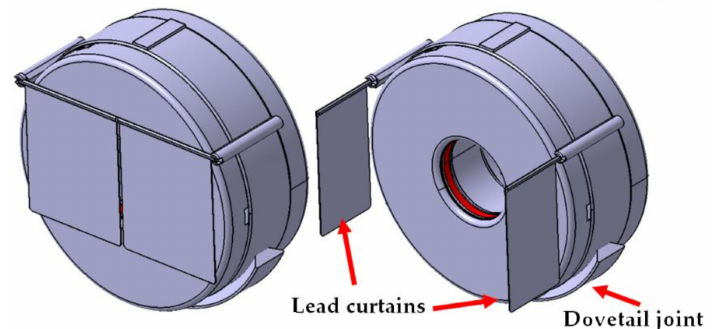
Figure 7. Modified gantry of CereTom with lead curtain and dovetail joint